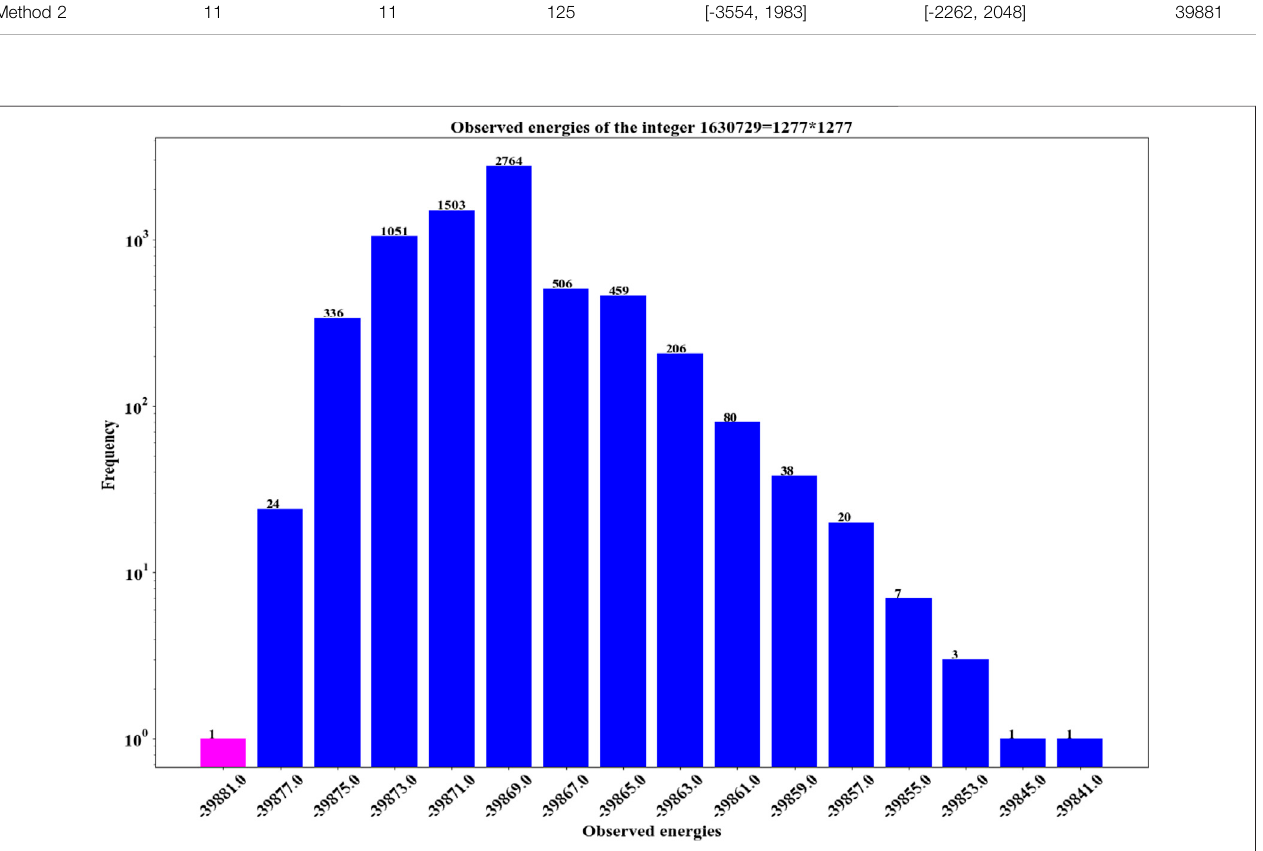
FIGURE 3 | Observed energies for the integer 1630729 after quantum